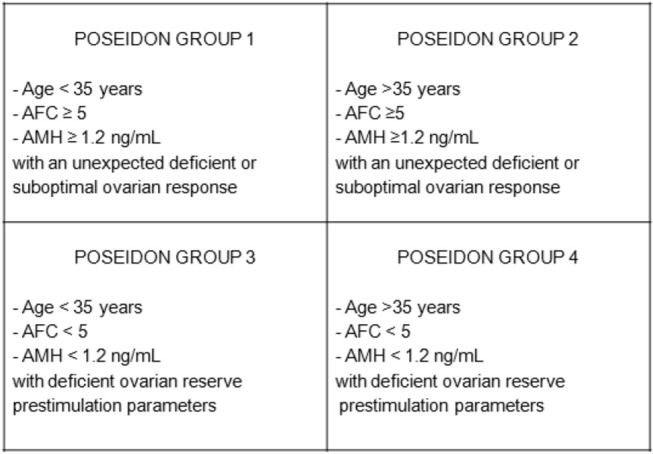
Characteristics of the 4 groups comprising the POSEIDON stratification of patients with poor ovarian response in assisted reproductive technology. AFC, antral follicle count; AMH, anti-Müllerian hormone; COH, controlled ovarian hyperstimulation. Modified from Humaidan et al. (6).